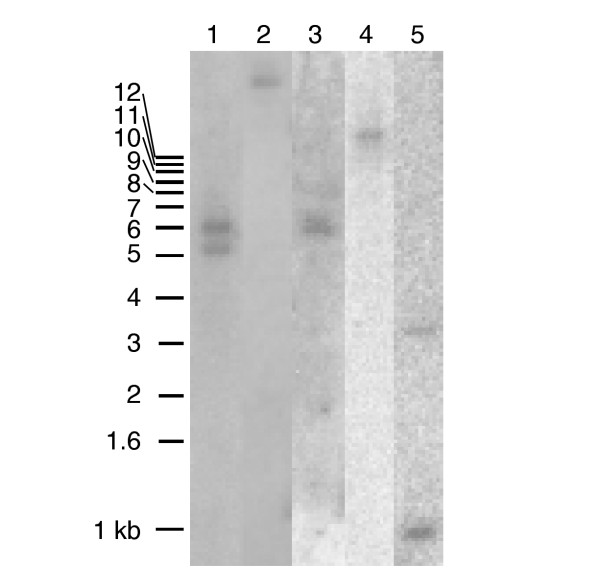
Cryptosporidium parvum genomic Southern blot. C. parvum genomic DNA, 5 μg per lane. Lanes were probed for the following genes: (1) aminopeptidase N; (2) glucose-6-phosphate isomerase; (3) leucine aminopeptidase; (4) pteridine transporter (BT-1); and (5) glutamine synthetase. Lanes (1-4) were restricted with BamH1 and lane (5) with EcoR1. The ladder is shown in 1 kb increments. See Additional data file 1 for probes and methods.